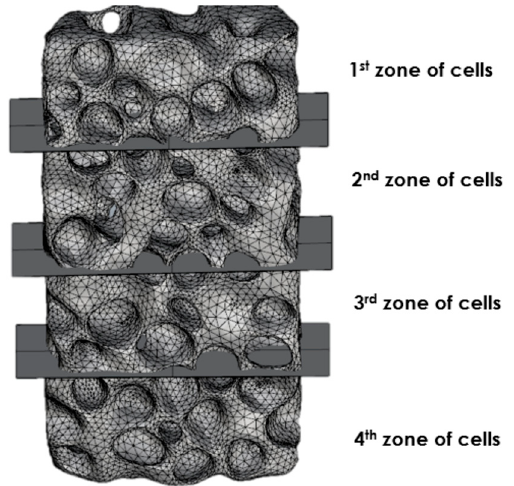
Figure 8. Partition of closed-cell numerical sample model into four zones for stress analysis throughout the volume model.